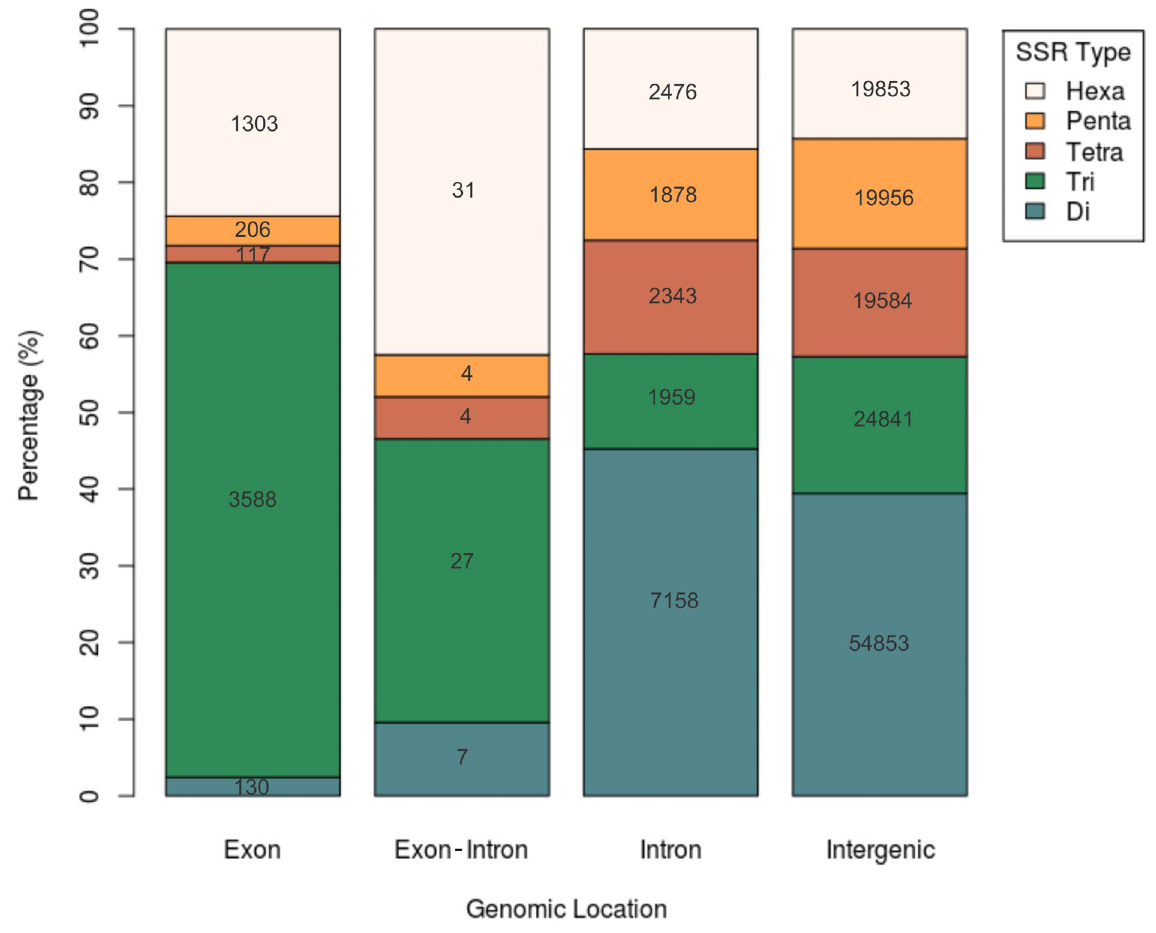
Figure 1. Distribution of SSR type according to genomic location.